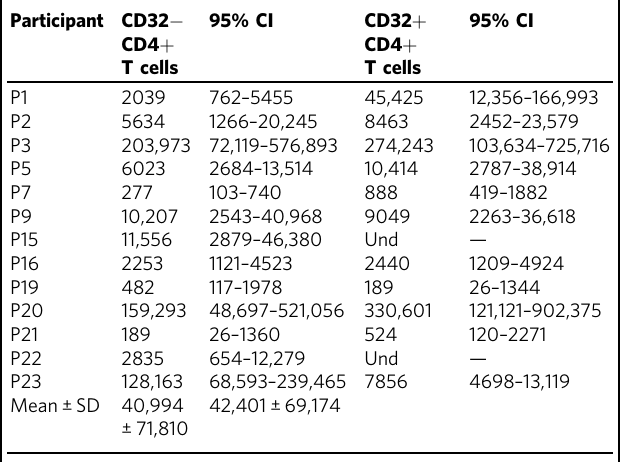
Table 2 IUPM values for CD32 − and CD32 + CD4 + T